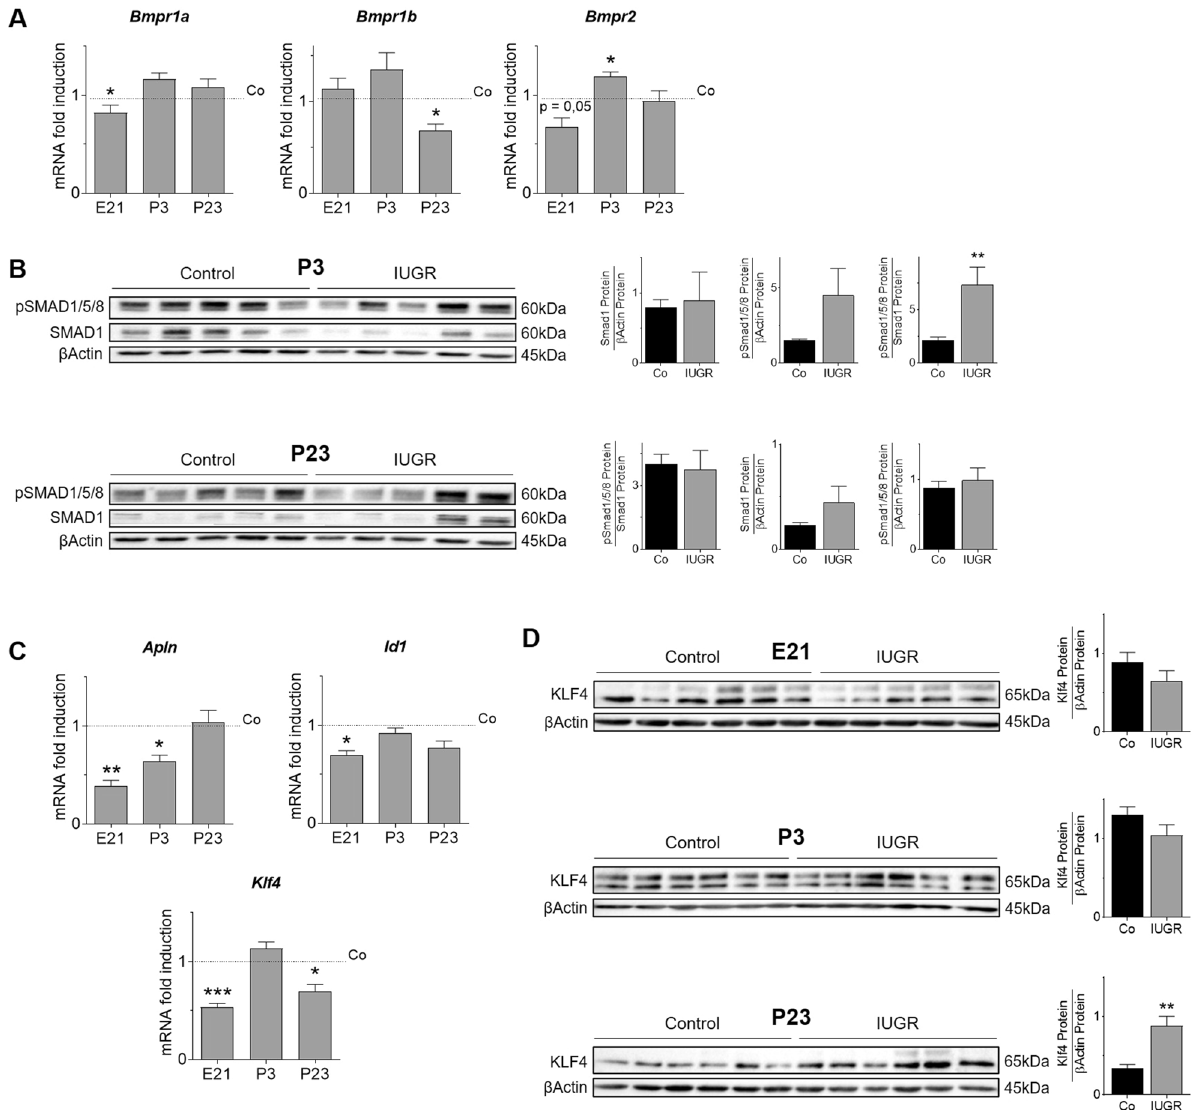
Figure 4. IUGR dysregulates gene expression and activation of the bone morphogenetic protein (BMP)- signaling pathway components. ( A ) Assessement of gene expression of BMP-Receptor 1a (Bmpr1a), Bmpr1b and Bmpr2 on embryonic day (E21), postnatal day 3 (P3), and P23 using qRT-PCR; Glyceraldehyde 3-phosphate dehydrogenase ( Gapdh ) served as housekeeping gene; the Control group was set at 1 (n = 10/group). ( B ) Immunoblots showing protein abundance of phosphorylated SMAD1/5/8 (pSMAD1/5/8) and total SMAD1 on P3 and P23; βActin served as loading control; pSMAD1/5/8 was related to βActin or to total SMAD1; densitometric summary data are shown next to the respective immunoblot (n = 5–6/group). (C) Measurement of mRNA expression of angiogenic transcription factors apelin ( Apln ), inhibitor of differentiation 1 ( Id1 ), and Krüppel-like factor 4 ( Klf4 ); Gapdh served as housekeeping gene; the Control group was set at 1 (n = 10/group) ( C ), as well as the protein expression of transcription factor Klf4 ( D ), with densitometric quantification shown below (n = 5–6/group). Mean ± SEM. A non-parametric T-test was used to compare IUGR to the control group, *p < 0.05, **p < 0.01, ***p <